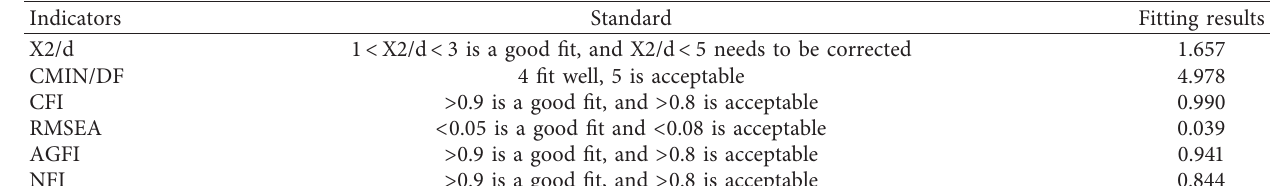
Table 3: Overall fit degree of the model.